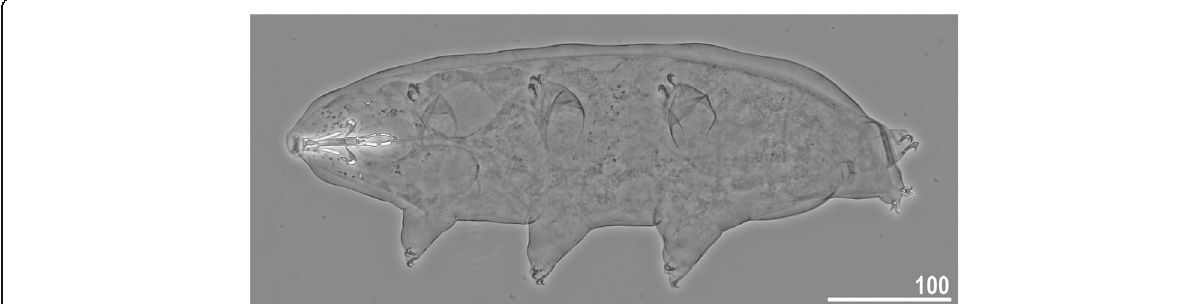
Fig. 3 Macrobiotus pallarii Maucci, 1954 from the topotypic population (IT.337) – habitus, adult specimen in dorso-ventral projection. Scale bar in μ m